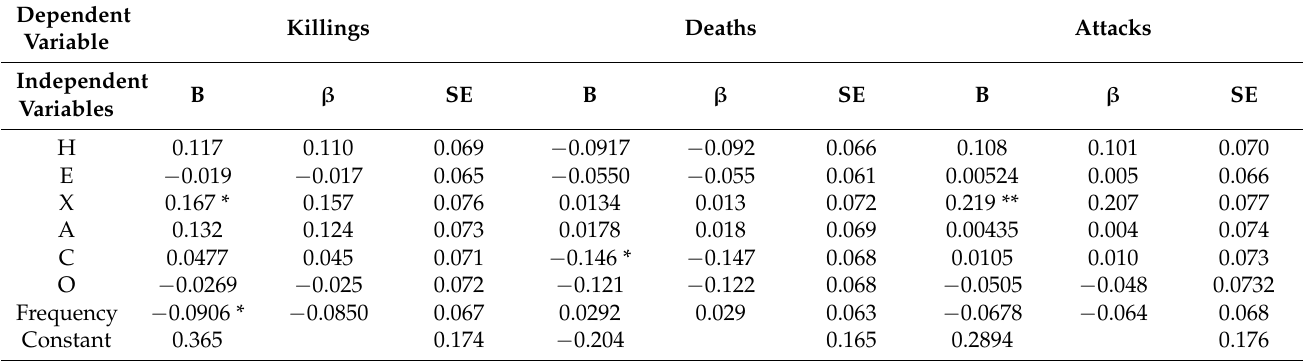
Table 6. Regression model, predicting the in-game